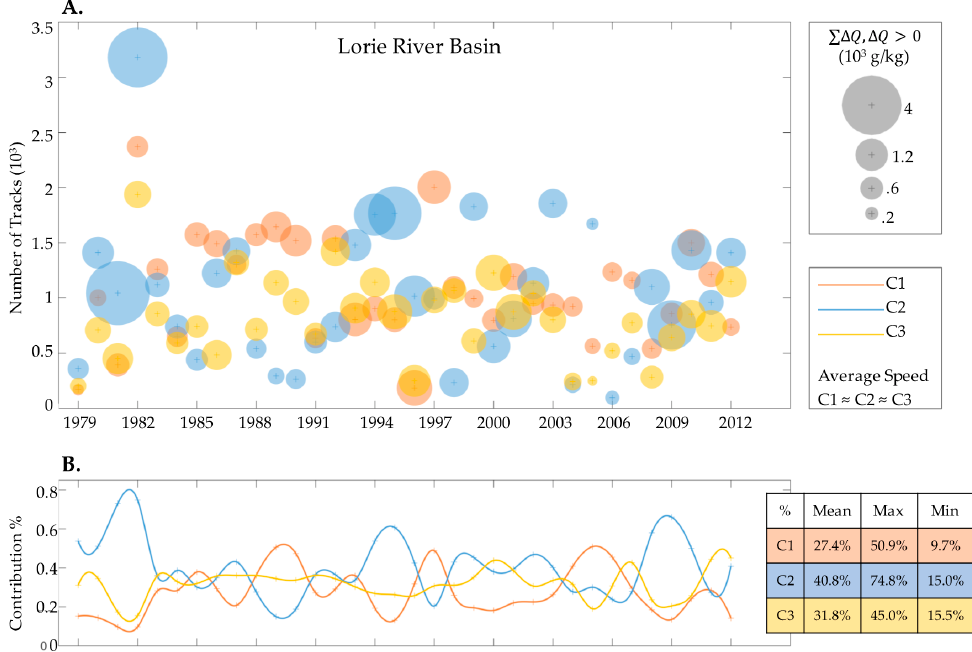
Figure 7. Contributing number of TMEs tracks and the associated moisture release from each cluster for the Loire river basin. ( A ) the colors of the circles are consistent with the clusters in Figure 4. The center of the colored circle shows the total number of tracks (vertical axis) from the identified source to the basin for each year (bottom axis). The size of the circle represents the total amount of moisture release of those tracks. The size is proportional to ( ∑ Δ Q ). The scale reference of the circle is the panel on the right. The order of the clusters’ traveling speeds is given for fast reference to Figure 4B. ( B ) the colored lines show the smoothed time series of the annual contribution of each cluster in terms of moisture release. The contribution is calculated as the percentage of the total. The summary statistics of their contributions (mean, maximum and minimum values) are tabulated in the colored table. The colors of the clusters are consistent over the entire paper.